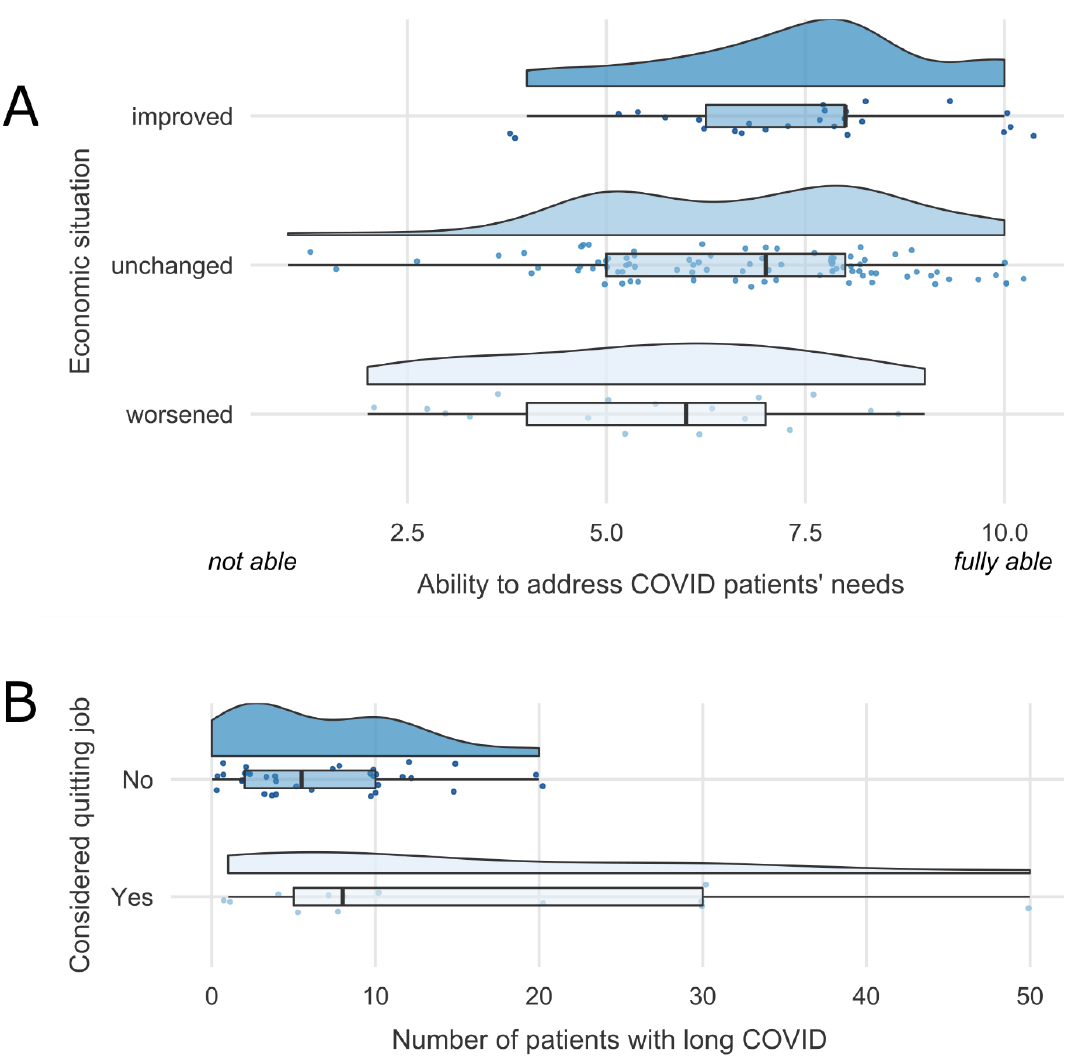
Figure 2. Influence of provision of care to patients with acute COVID-19 or long COVID on working conditions in GP practices. ( A ) Baseline 2021: GPs who reported a worsening of the economic situ- ation of their practice since the outbreak of the pandemic rated their ability to address COVID pa- tients’ needs as lower. ( B ) Follow-up 2022: GPs who considered quitting their job in the last 12 months currently treated more patients with long COVID.